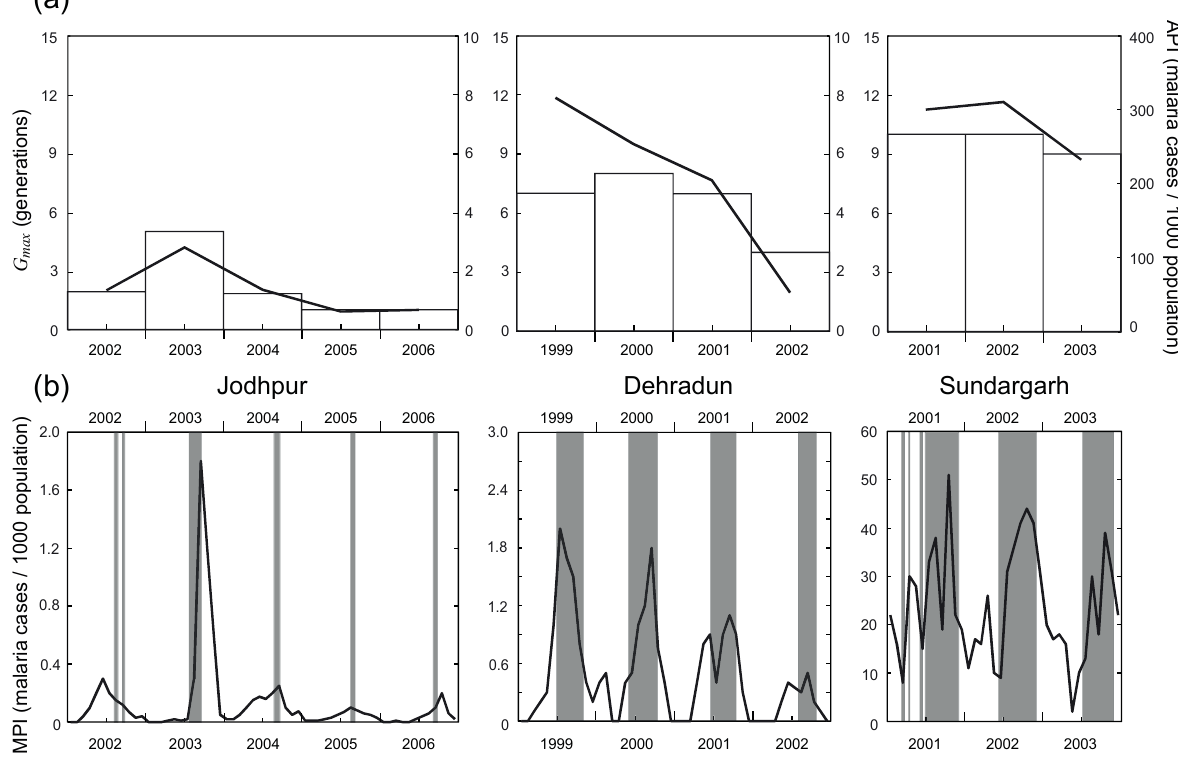
Figure 4. ( a ) Observed interannual variations in annual parasite index (API, solid line) and simulated maximum number of Anopheles generations ( G , histogram), and ( b ) Observed max seasonal variations in monthly parasite index (MPI, solid line) and simulated adult emergence period ( τ , solid gray bars) at three representative sites. Note that the solid adult gray bars do not represent the magnitude of adult emergence within these